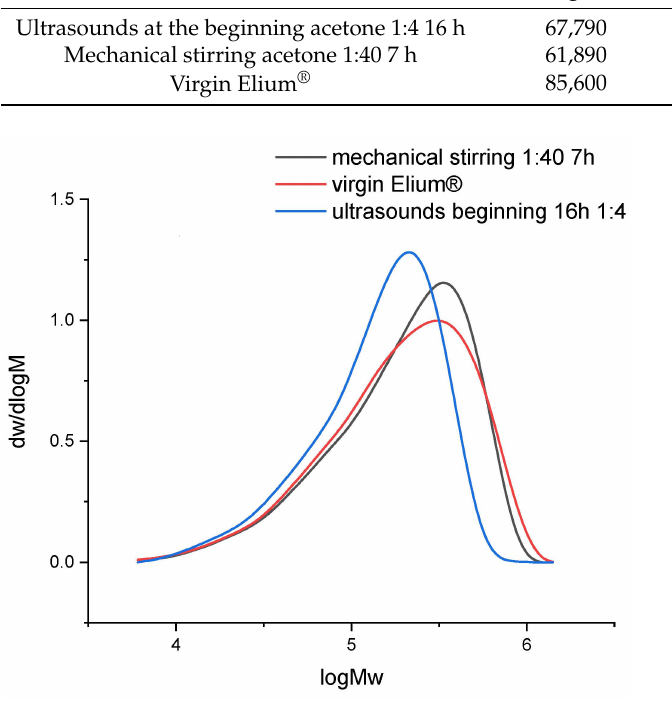
Figure 14. Molecular weights distribution of virgin Elium ® and recycled Elium ® resin after